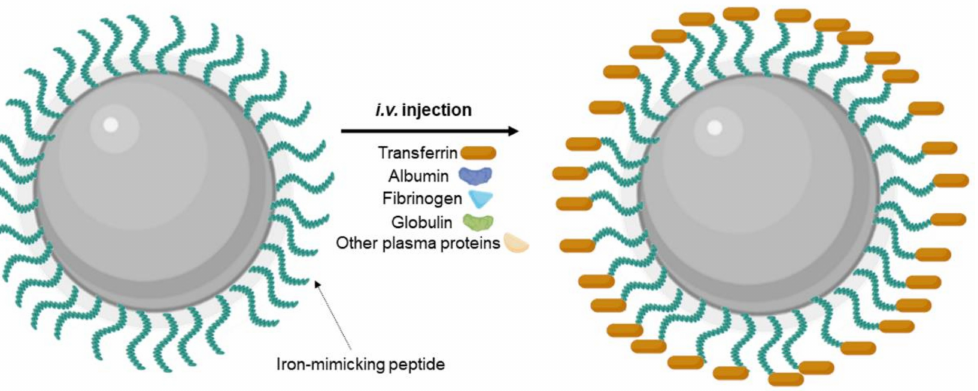
Figure 9. Schematic representation of Tf protein corona formation after i.v. injection of NPs modified with iron-mimicking